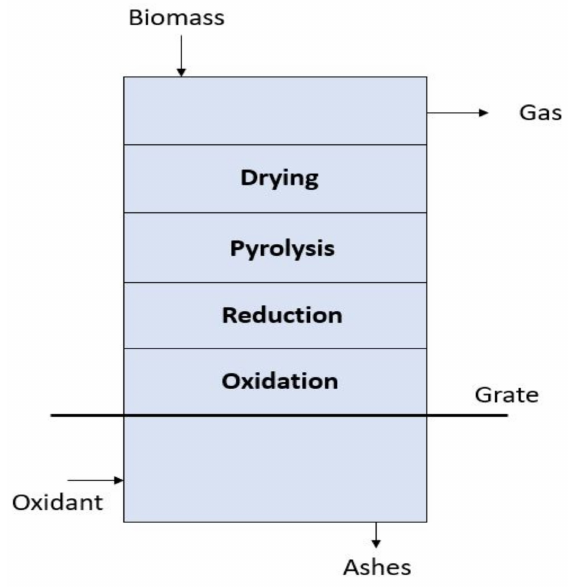
Figure 1. Fixed-bed updraft